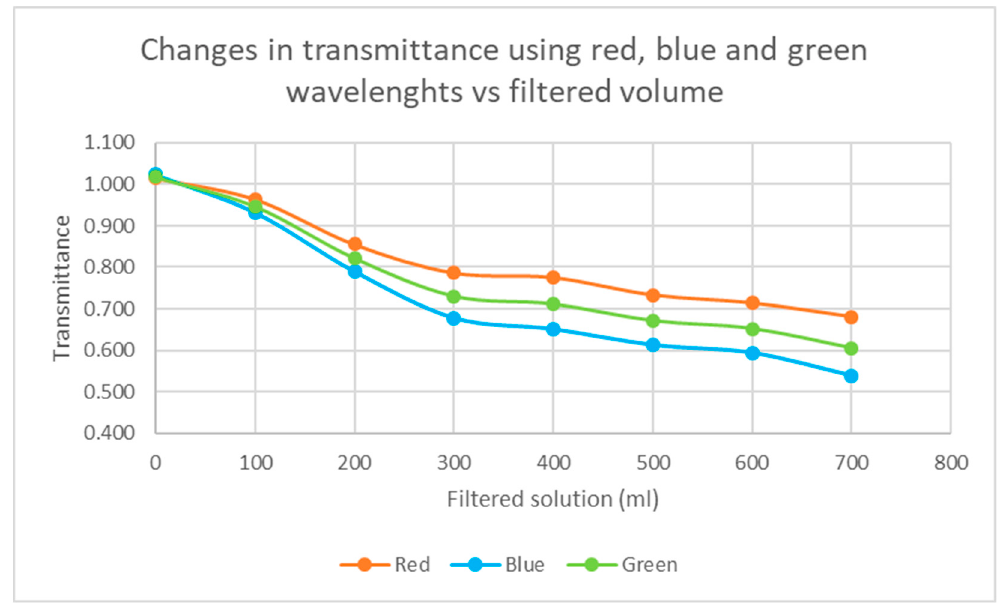
Figure 4. Results of the filter wetting test using a particle soot absorption photometer PSAP. Black carbon containing solution was made from wood-burning soot and ultrapure Milli-Q water.